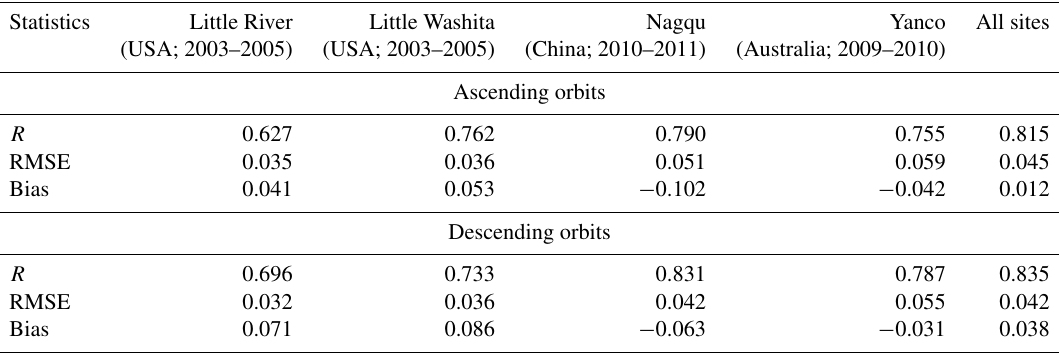
Table 4. Summary of satellite LPDR soil moisture retrieval accuracy in relation to in situ surface soil moisture measurements from four globally distributed validation watersheds.